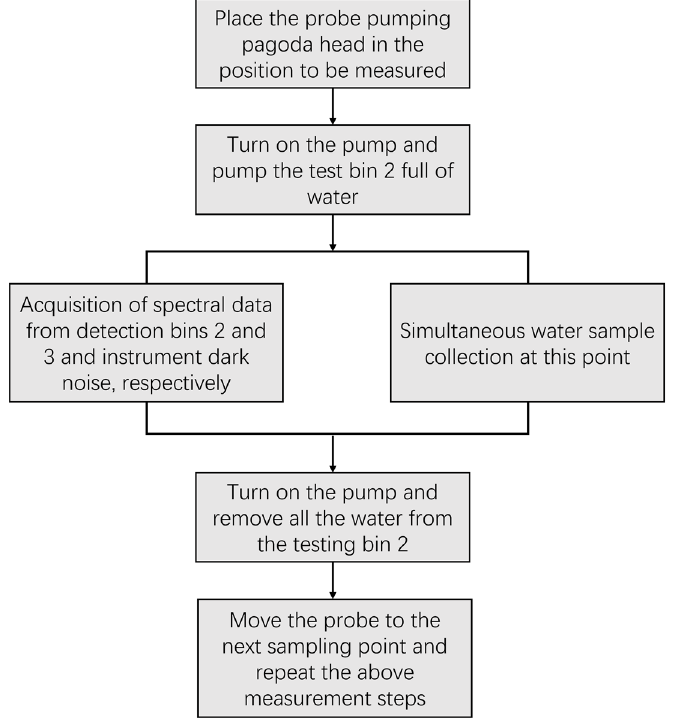
Figure 4. Data collection flow. Figure 5. Data collection